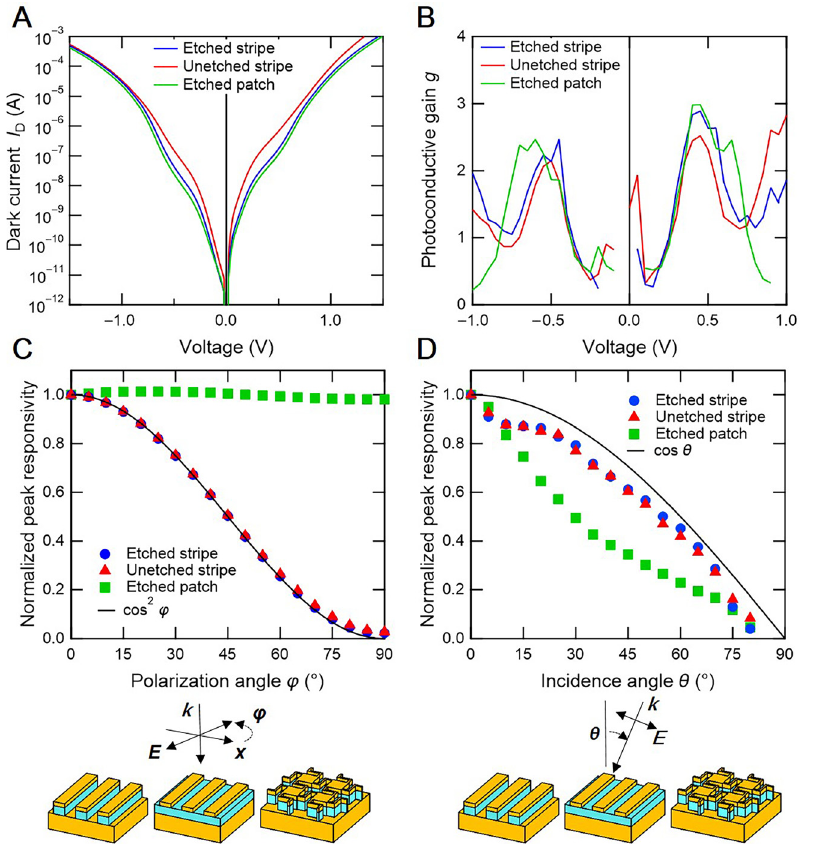
Figure 4: Device performance versus morphology for etched and unetched stripe detectors from Figure 3D, E and wired patch detector from Ref. [6]. A) Dark current I D , B) photoconductive gain g , C) polarization angle-dependent R ,andD) incidenceangle- dependent unpolarized normalized R . In- sets below C) and D) illustrate the geometry of the measurement. Etched patch detector schematic taken from Ref. [6], with patch length L = 1.19 μ m, P = 2.0 μ m, and thin Z-shape wires with width W = 100 nm and folding length S = 0.29 μ m k and E indicate incoming